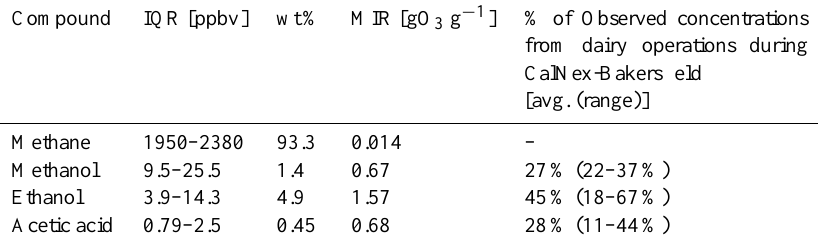
Table 5. Interquartile range ( Q 25 − Q 75 ) at Bakersfield shown with the source profile of dairy operations (determined using ground site Bakersfield data and aircraft measurements in the San Joaquin Valley), and the ozone formation potential (MIR) of individual components.